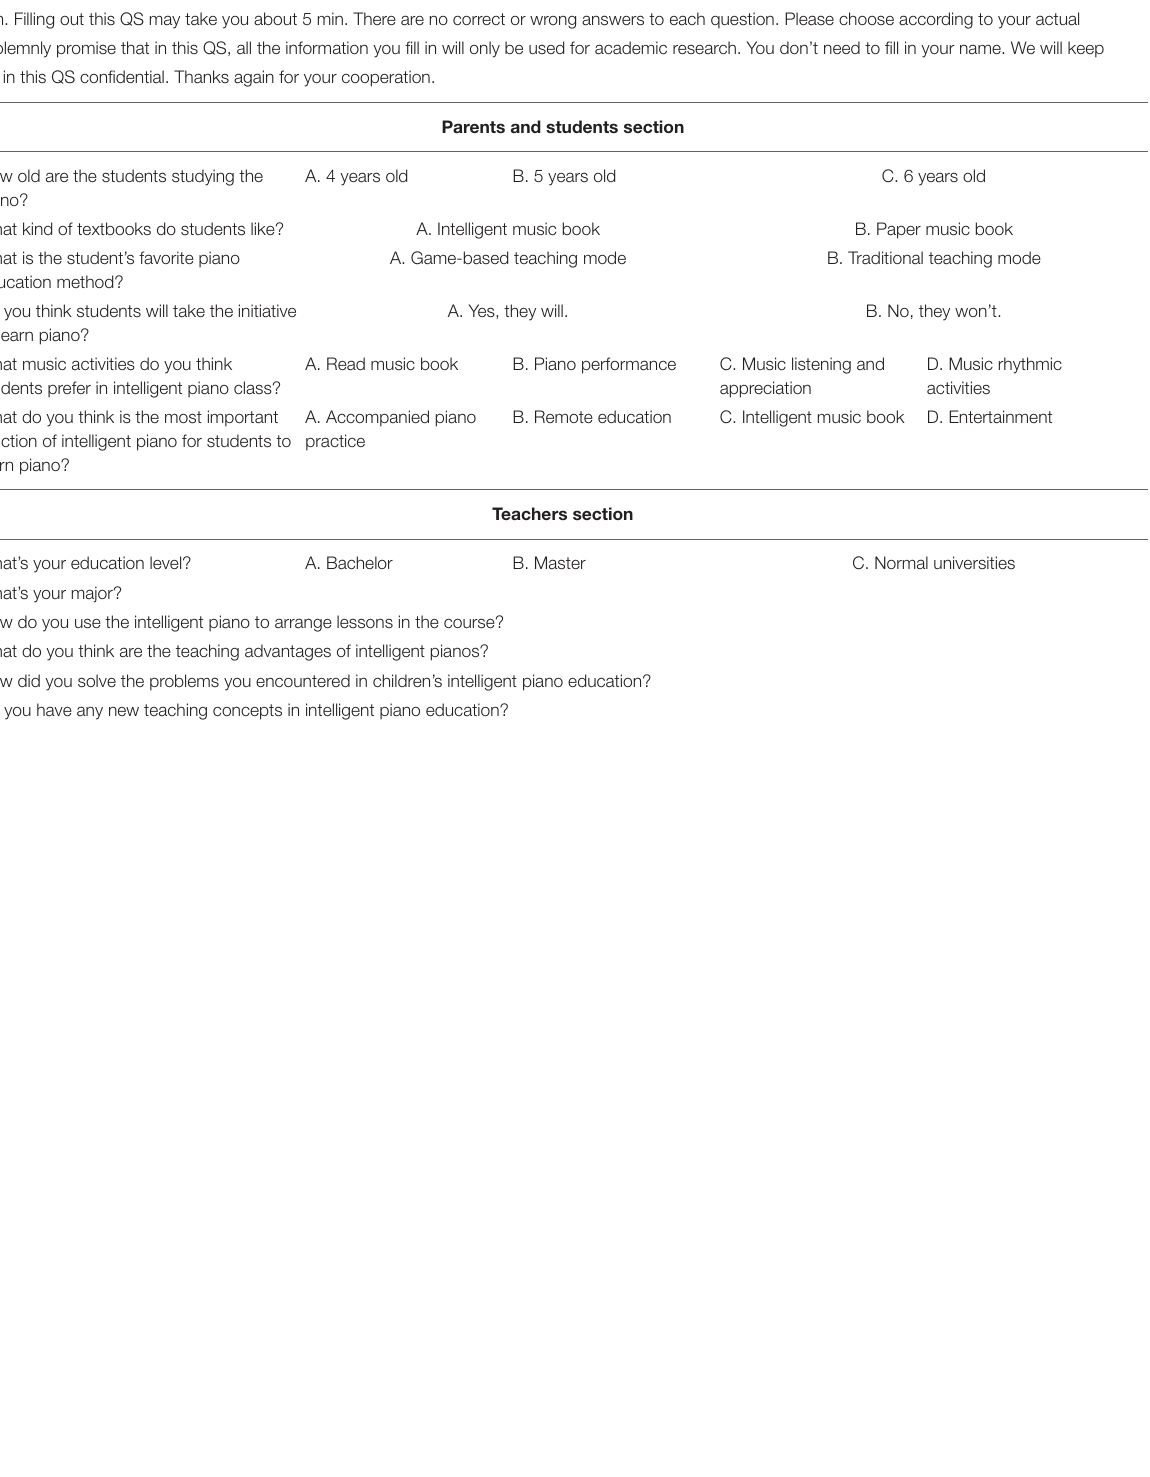
TABLE A1 | QS (Questionnaire Survey) table. QS of intelligent piano based on deep